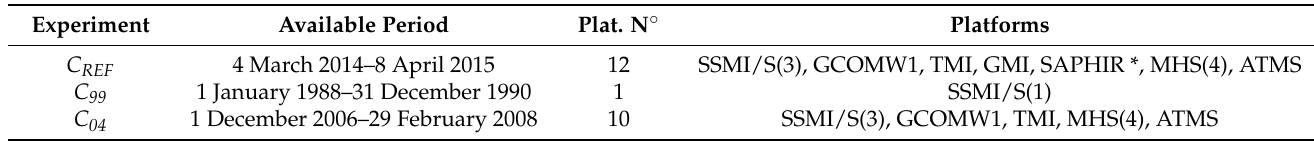
Table 1. The adopted data denial experiments and their respective constellation configurations, based on the number of platforms available for each corresponding period. Experiment Available Period Plat. N ◦